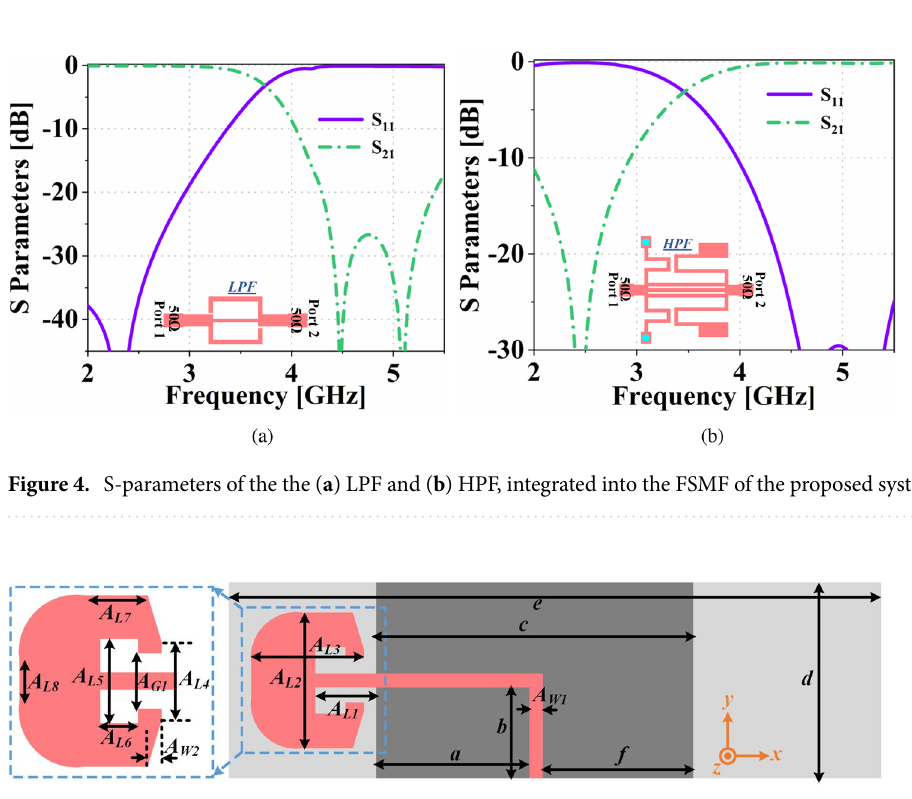
Figure 5. Proposed antenna for fixed band communication application.